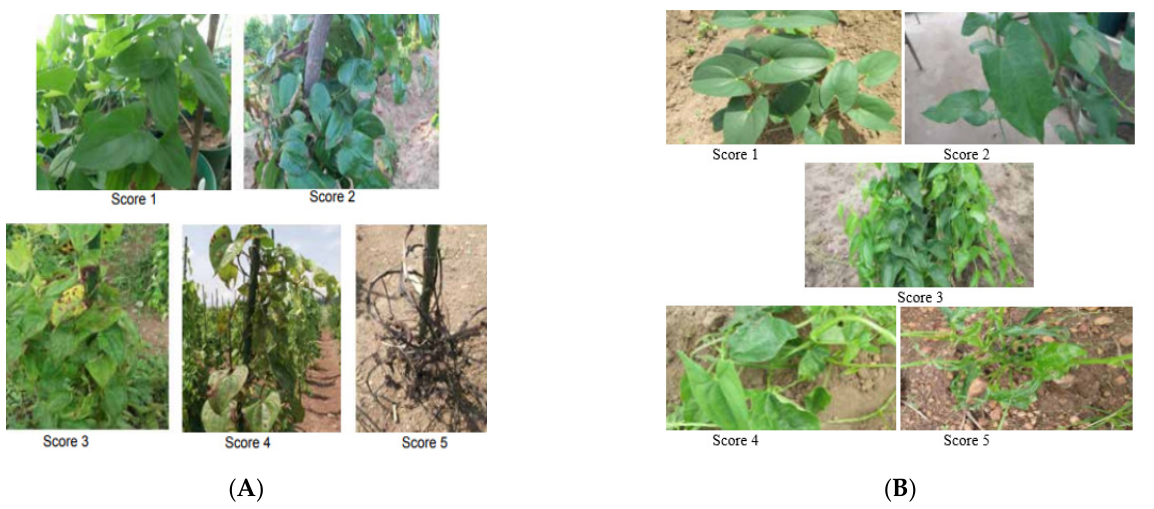
Figure 1. Visual scale for yam anthracnose ( A ) and yam mosaic virus diseases ( B ) scoring (pictures from Asfaw, 2016 [20]).